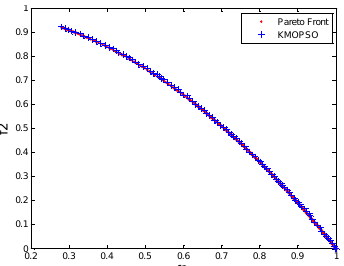
Fig. 15. Pareto fronts produced by KMOPSO for ZDT6.